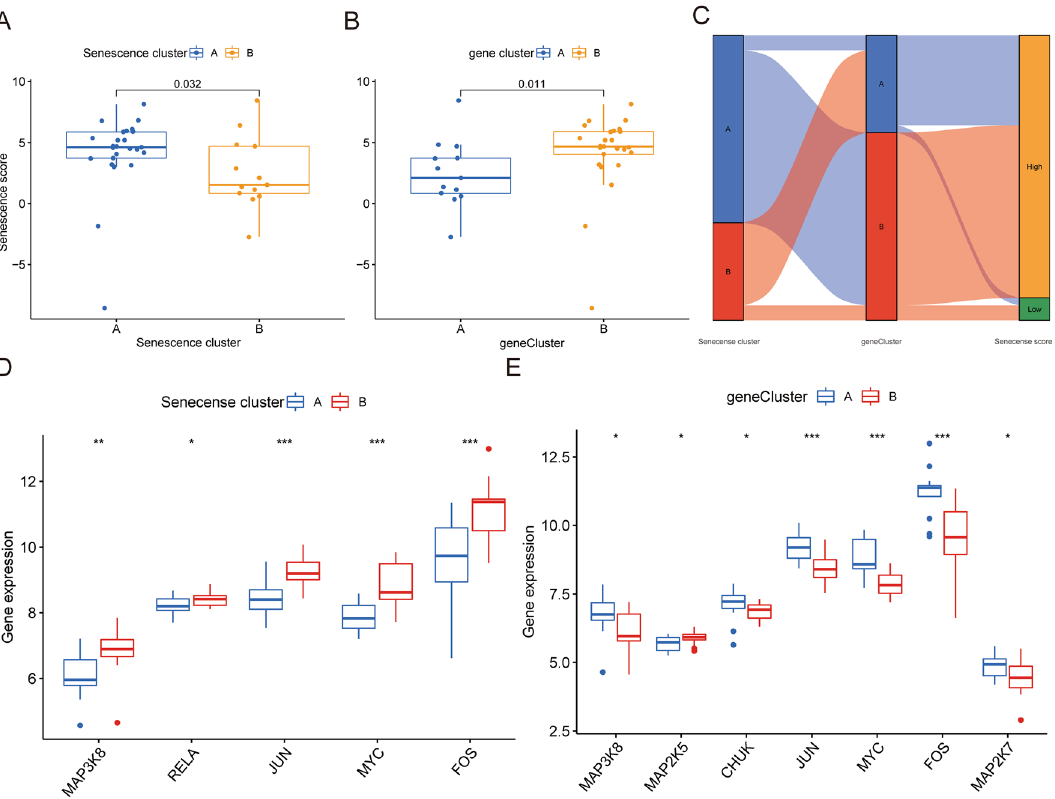
Figure 6. Construction of senescence signatures. ( A ) The senescence score in the two senescence clusters. ( B ) The senescence score in the two gene clusters. ( C ) Alluvial diagram showing the changes of senescence clusters, gene cluster and senescence score. ( D ) Bloxplot showing the gene expression of MAPK pathway in the two senescence clusters. ( E ) Bloxplot showing the gene expression of MAPK pathway in the two senescence gene clusters. (All figures *represents p < 0.05, **represents p < 0.01, ***represents p < 0.001) MAPK, mitogen-activated protein